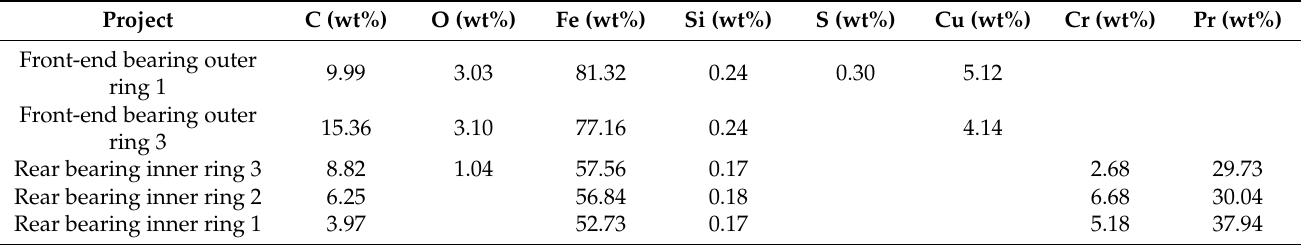
Table 1. EDS results of the wear delamination of the inner and outer rings of the front-end and rear